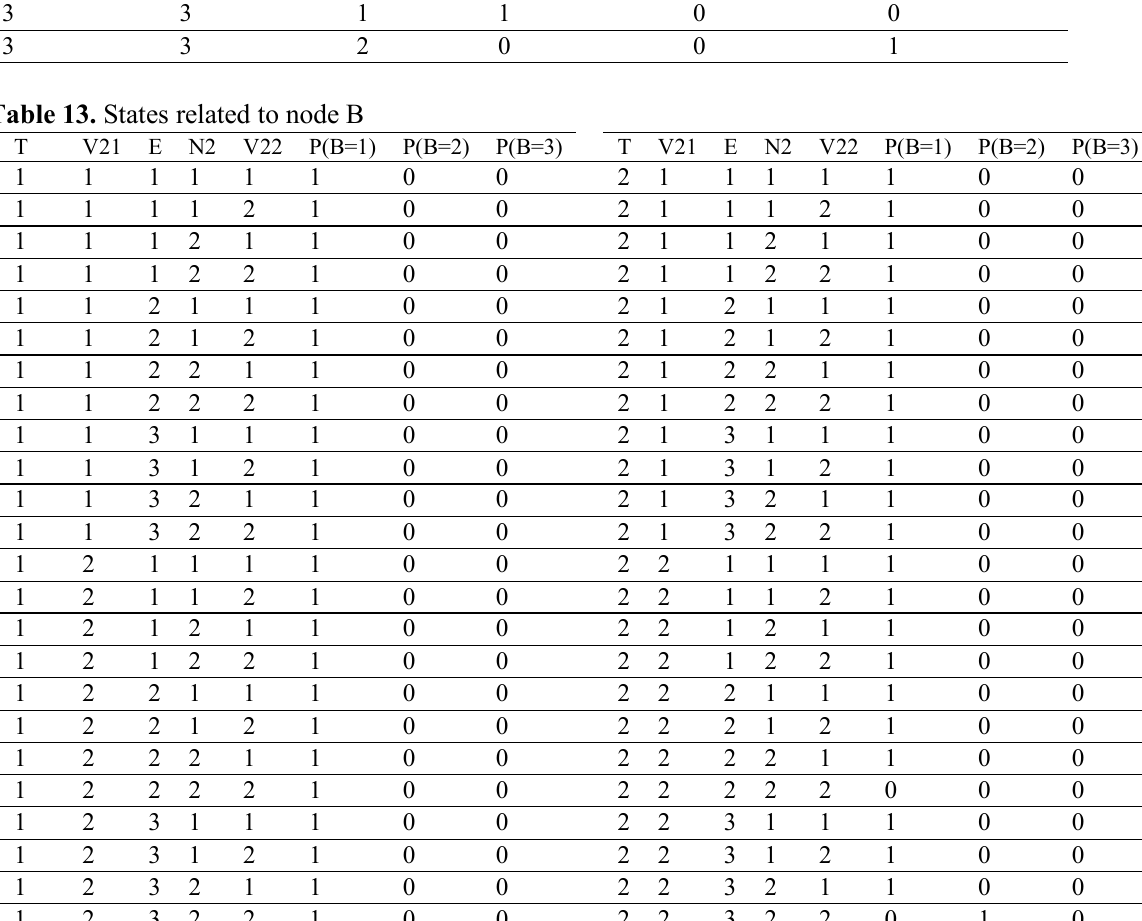
Table 13. States related to node